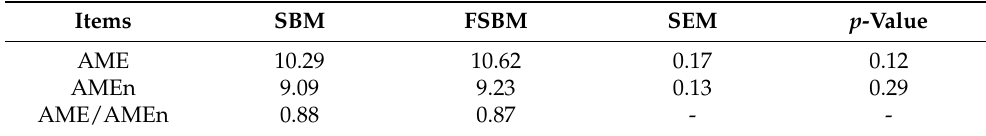
Table 4. Metabolizable and nitrogen-corrected metabolizable energy of SBM and FSBM (dry matter basis, MJ/kg).